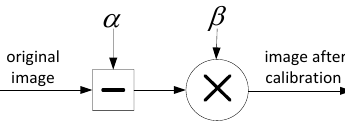
Figure 4. Radiometric calibration modular structure diagram 3.2 Gray Level Histogram Statistical Module